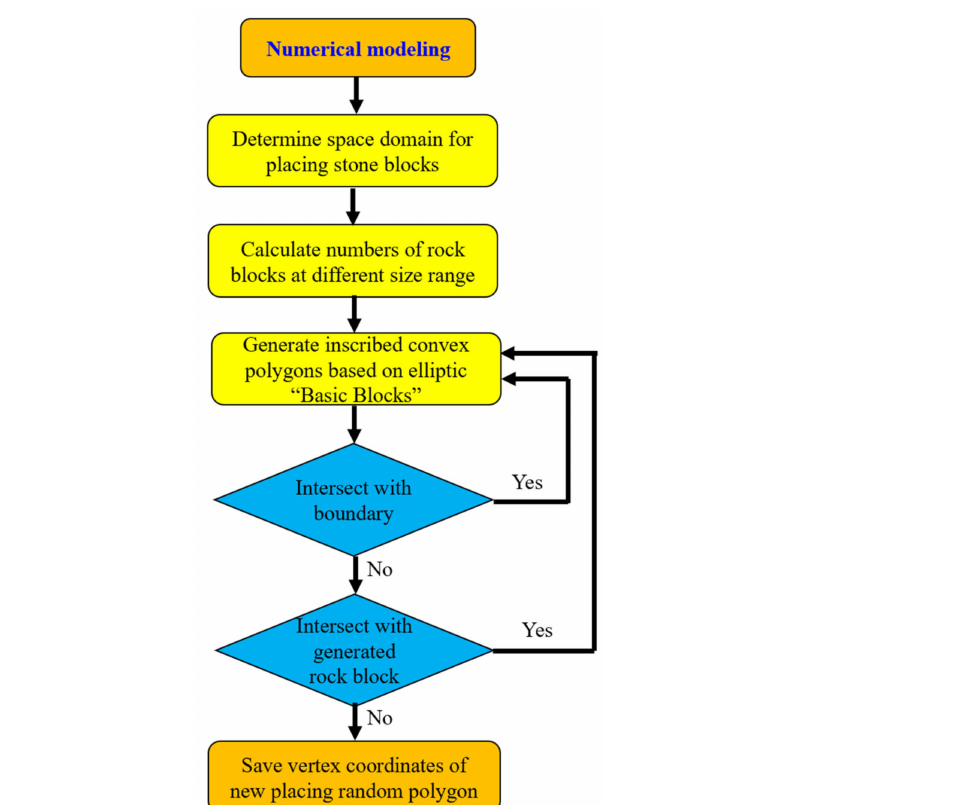
Figure 2. Modeling process of S-RM with random